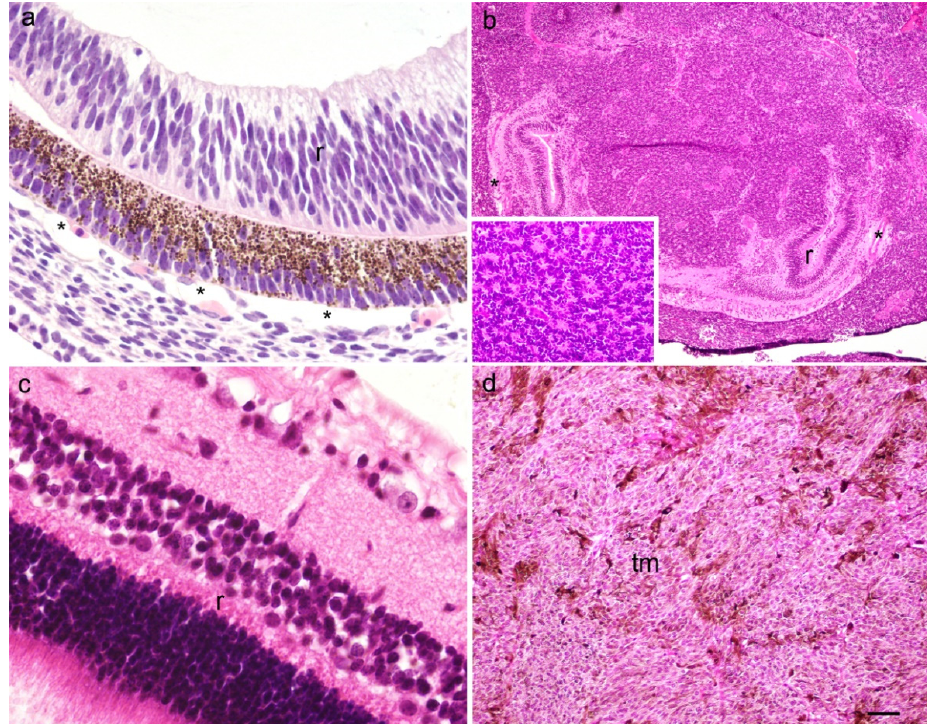
Figure 1. A section through the eye of an 8-week human embryo ( a ), retinoblastoma ( b ), normal human eye ( c ) and myxoid melanoma ( d ); inset on the panel ( b ) present Flexner–Wintersteiner rosette, r—retina, *—choroidea, tm—tumor tissue. Haematoxylin and Eosin staining, scale bar (( a , c ) = 25 µ m), (( b ) = 6 µ m), (( d ) = 12 µ